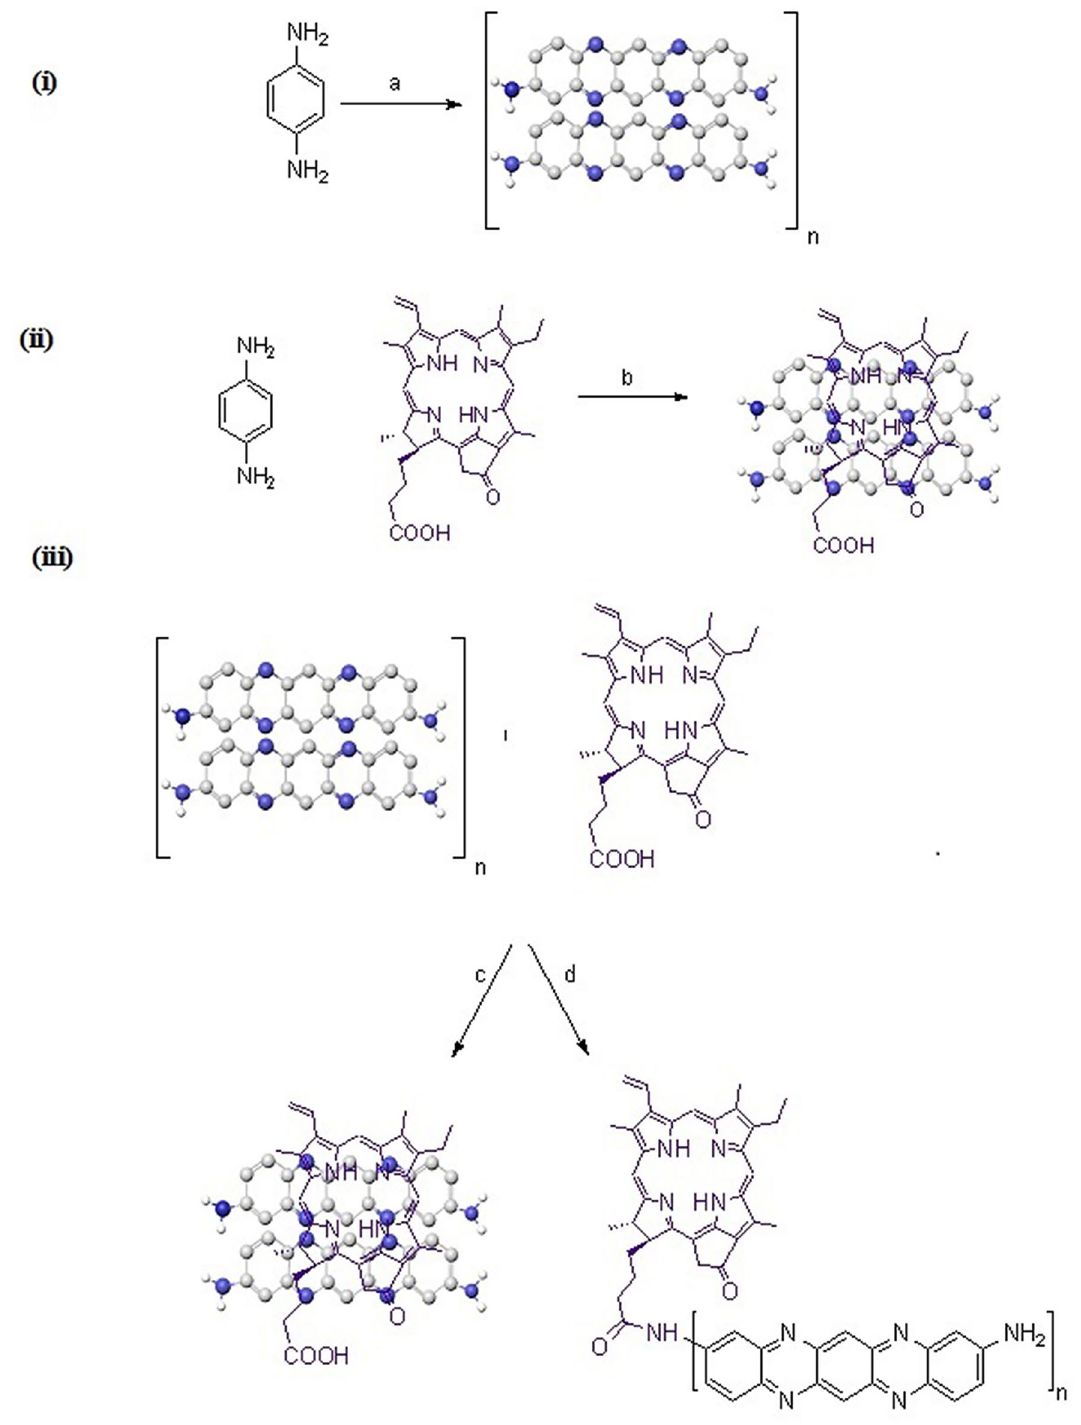
Figure 1. (i) Synthesis of R-CPDs and conjugates, ( a ) FeCl2, 80 °C, (ii) one pot synthesis of PPa-PD3, 120 °C, (iii) Conjugation of PPa-PD1 and PPa-PD2, ( c ) sonication of 48 h, ( d ) DIPEA,